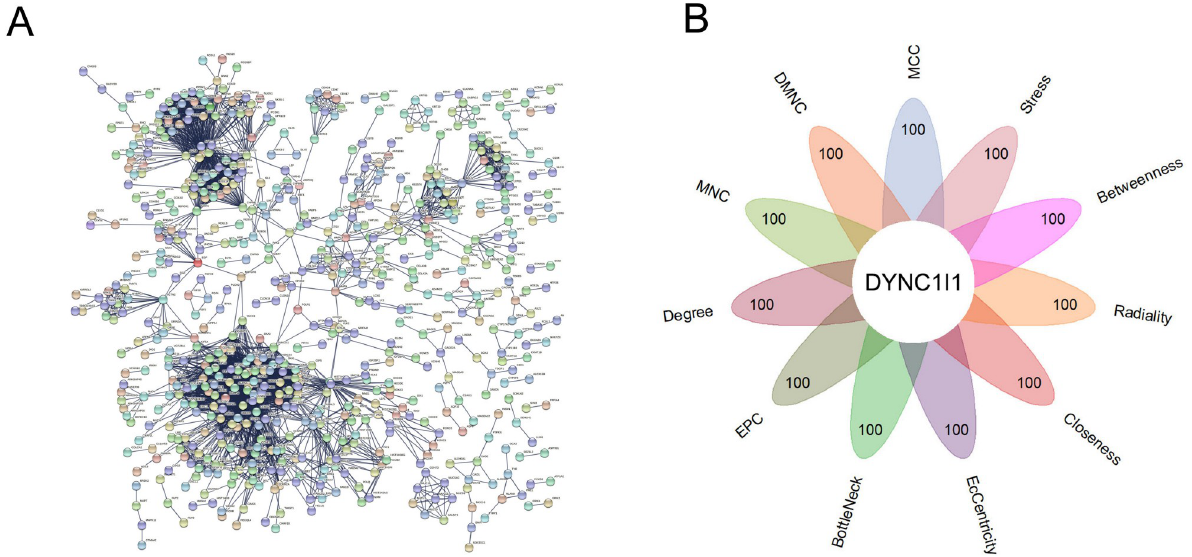
Fig 3. Identify the hub gene. A. Use STRING online database to build a PPI network that interacts with DYNC1I1; B. Use Cyto-Hubba software to identify the hub gene. DYNC1I1 was the only hub gene that intersects among the top 100 genes obtained by each of the 11 algorithms.